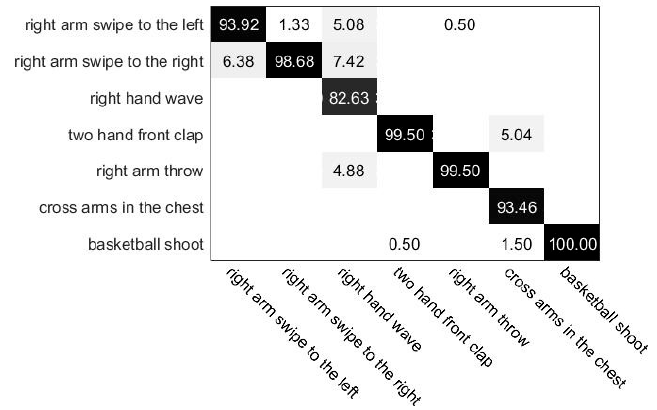
Figure 6. Confusion matrix of our proposed method in UTD-MHAD dataset.